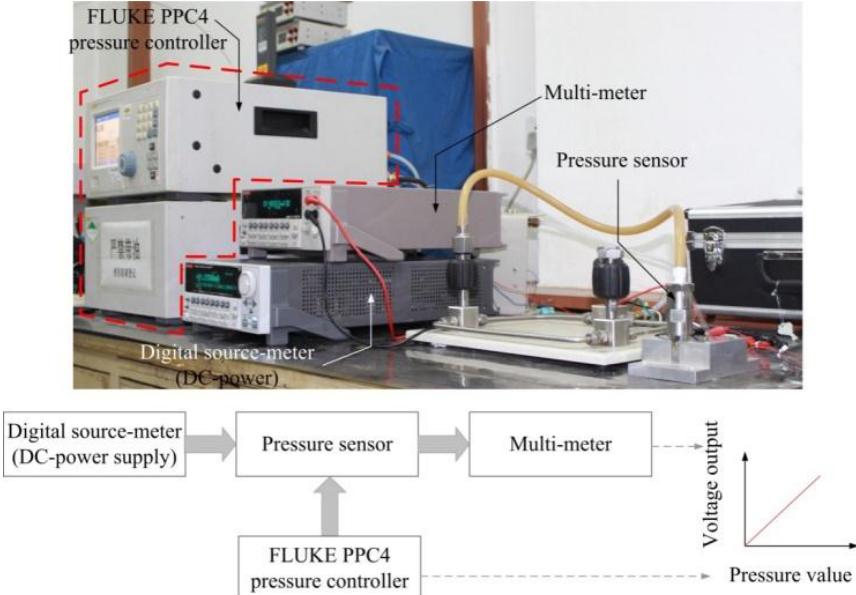
Figure 26. The pressure calibration facilities used in sensitivity experiment.